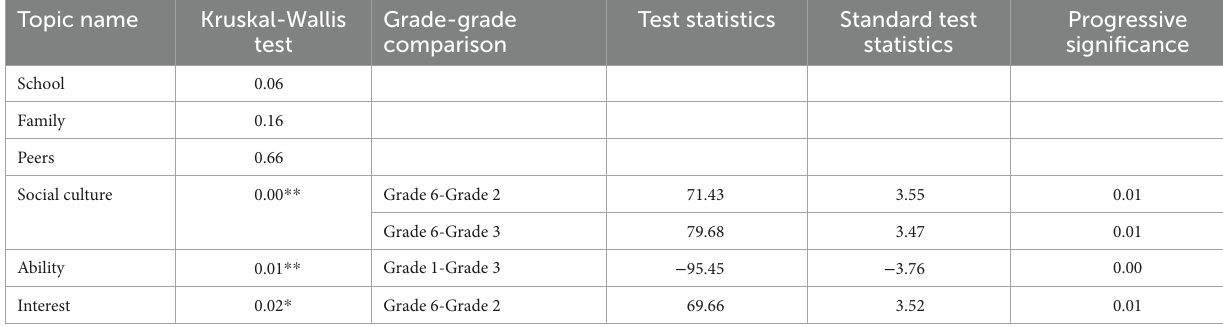
TABLE 4 Changes in sentiment distribution of topics in different